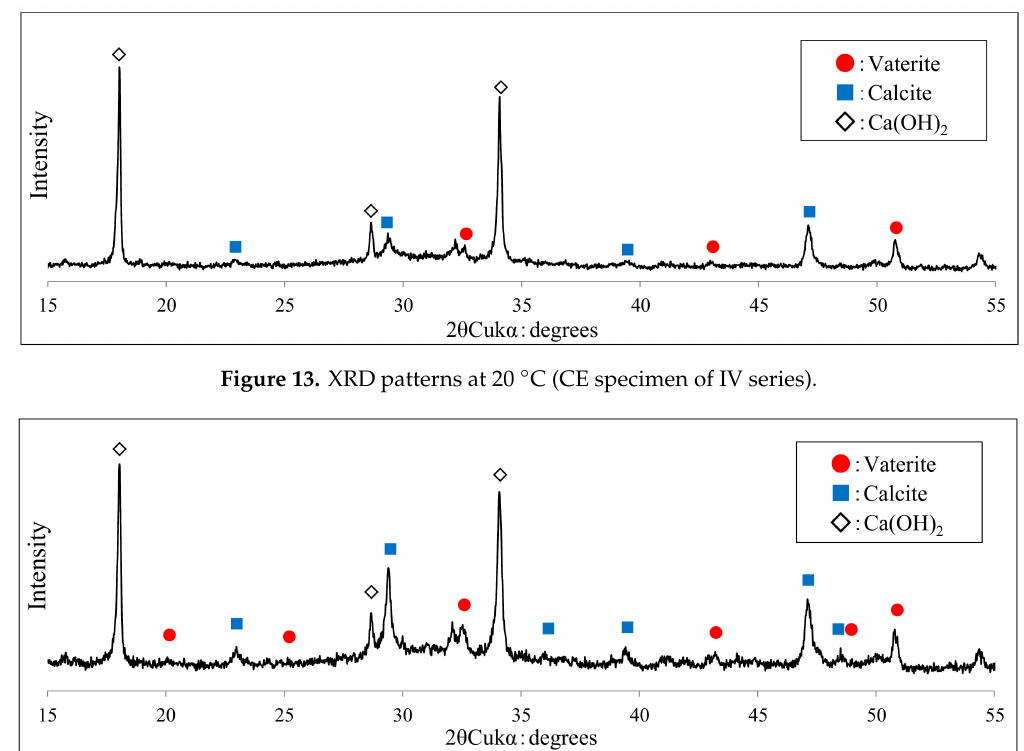
Figure 14. XRD patterns at 40 ◦ C (CE specimen of IV